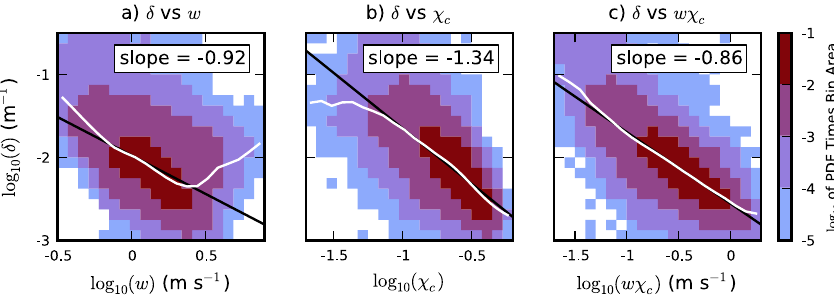
Fig. 12. Joint probability density functions multiplied by bin area ( P(x,y)1x1y ) for individual clouds in the combined BOMEX and ARM LES output of log 10 (δ) versus (a) log 10 of vertical velocity, (b) log 10 of critical mixing fraction, and (c) log 10 of vertical velocity times critical mixing fraction. PDFs are plotted using a logarithmic scale. White lines indicate the mean log 10 (δ) value as a function of the x axis variable, and black lines show linear least-square best fits of log 10 (δ) versus the x axis variable.